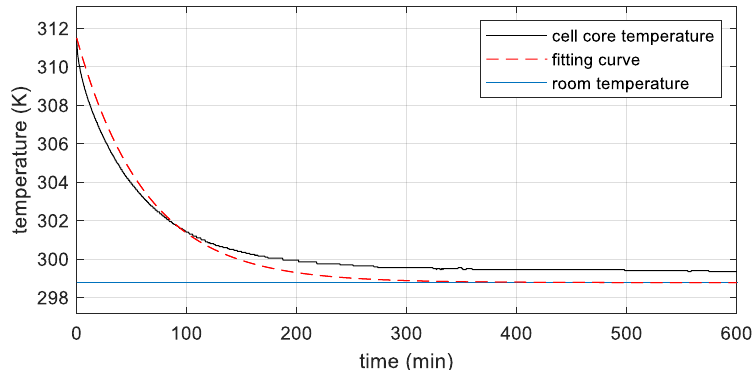
Figure 7. Experimental thermal relaxation for cell thermal capacity estimation. Black curve: cell core temperature. Dashed red curve: the fitting results achieved with Equation (14). Blue curve: room temperature.